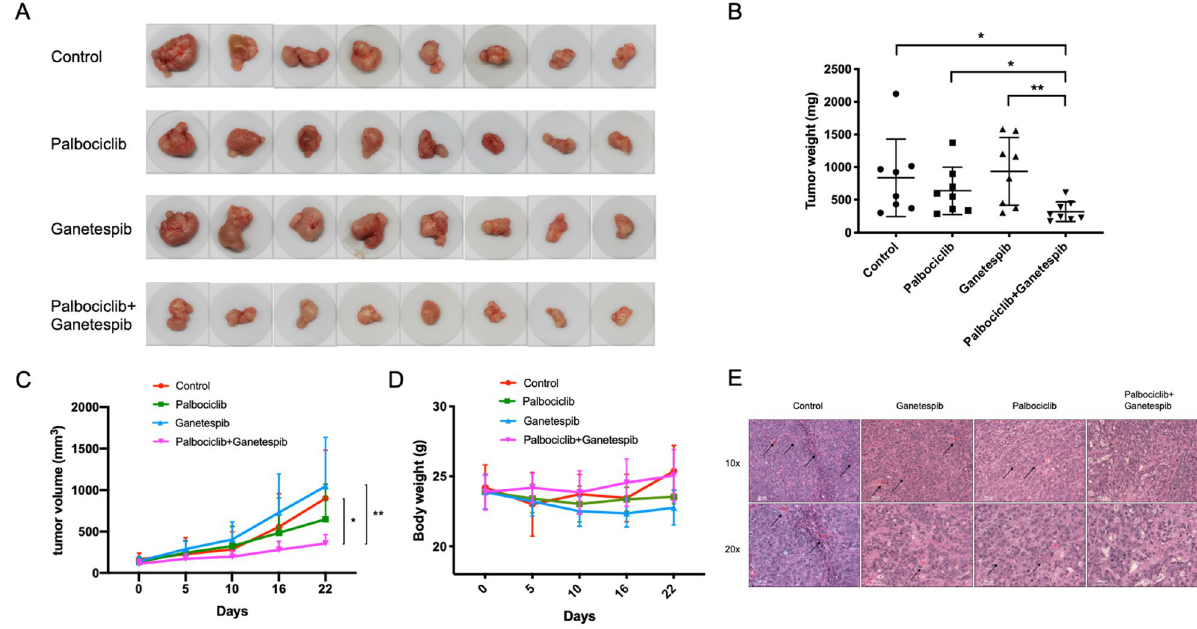
Figure 6. Combination treatment with palbociclib and ganetespib inhibits tumor growth in vivo . ( A ) Tumors excised from HT29 xenografts in nude mice. ( B ) Tumor weight quantification of excised tumors. ( C ) Tumor volume measured over time. ( D ) Body weight of mice in different treatment groups. ( E ) Combination treatment inhibits microvessel formation in tumors in vivo. Statistical analysis was performed using unpaired two-tailed t test. Mean ± SD was shown. * p < 0.05, ** p <